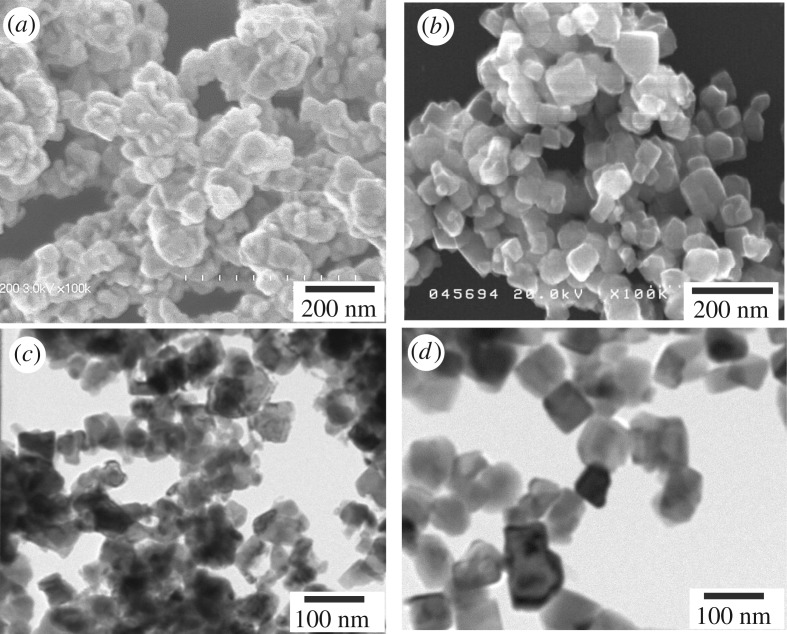
SEM images of core–shell α″-Fe16N2/Al2O3 and cube-like Fe3O4 MNPs: (a) α″-Fe16N2/Al2O3 and (b) Fe3O4 MNPs before dispersion; (c) α″-Fe16N2/Al2O3 and (d) Fe3O4 MNPs after dispersion.